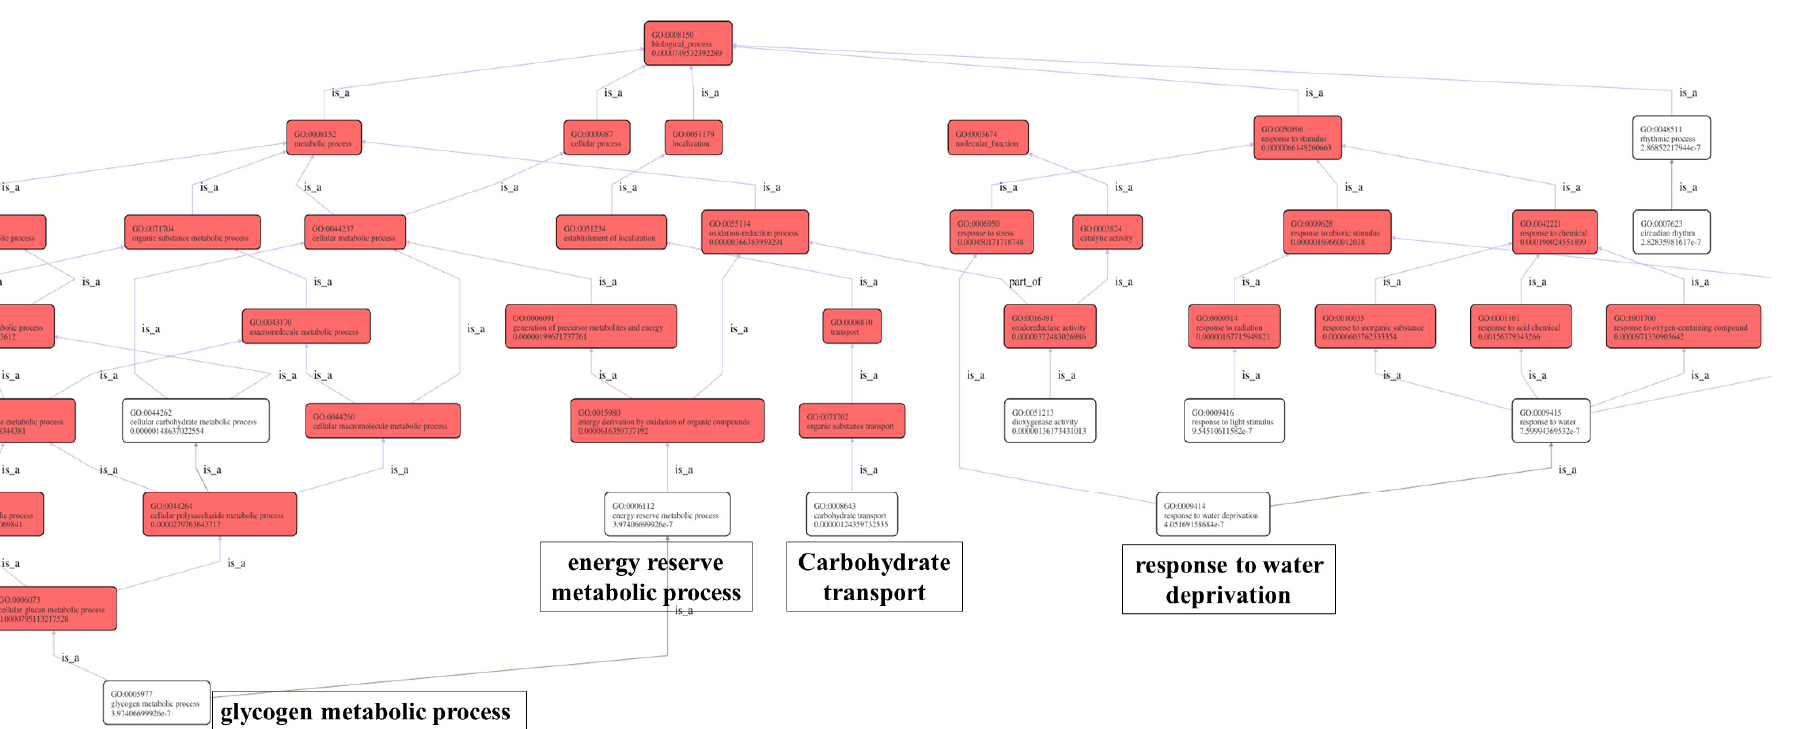
Figure 6. GO directed acyclic graph. The boxes show the GO IDs and annotations of the GO items. Red indicates the GO items with significant enrichment; the redder the color, the more significant the enrichment. The connecting line indicates the relationship between the two GOs. Please refer to http://geneontology.org/docs/ontology ‐ relations/ (accessed on 25 September 2022) for the relationship explanation.